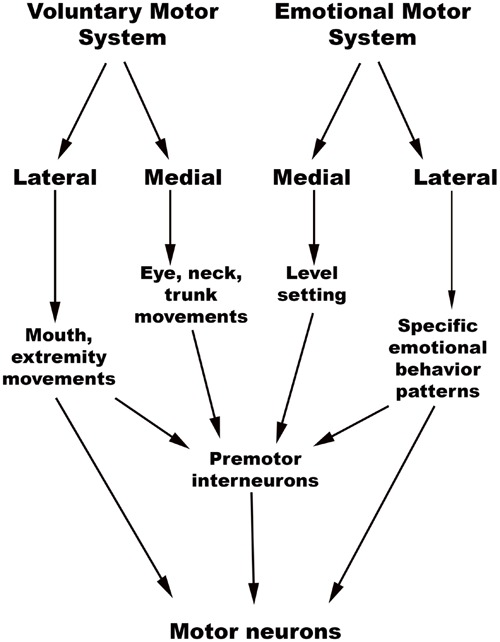
Holstege’s conception of the Emotional and Somatic motor systems. (Adapted from Holstege, 2016).